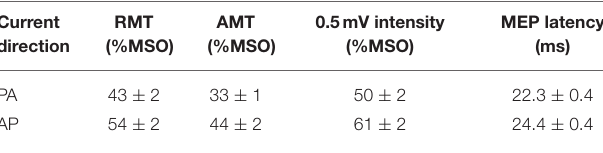
TABLE 1 | Motor thresholds and MEP latencies for each TMS current